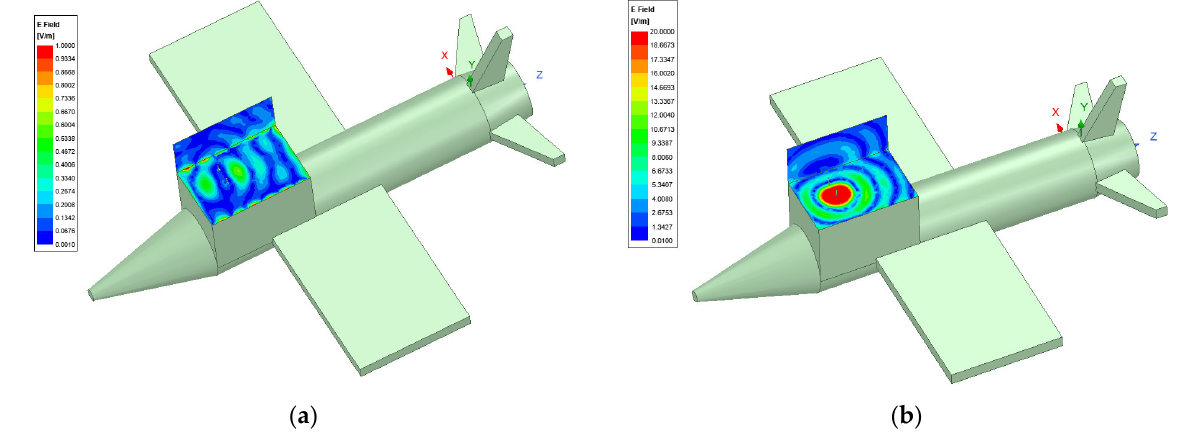
Figure 4. ( a ) Electromagnetic field around the antenna system before the echo cancellation; ( b ) Electromagnetic field around the antenna system after the echo cancellation.